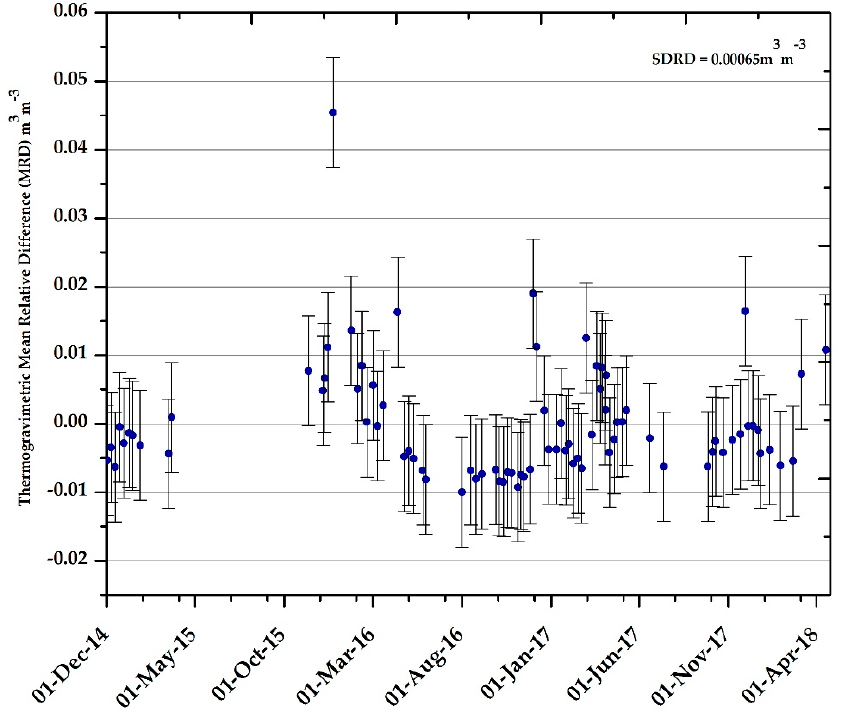
Figure 3. Mean relative difference of thermogravimetric VSM (samples collected during 83 field visits).